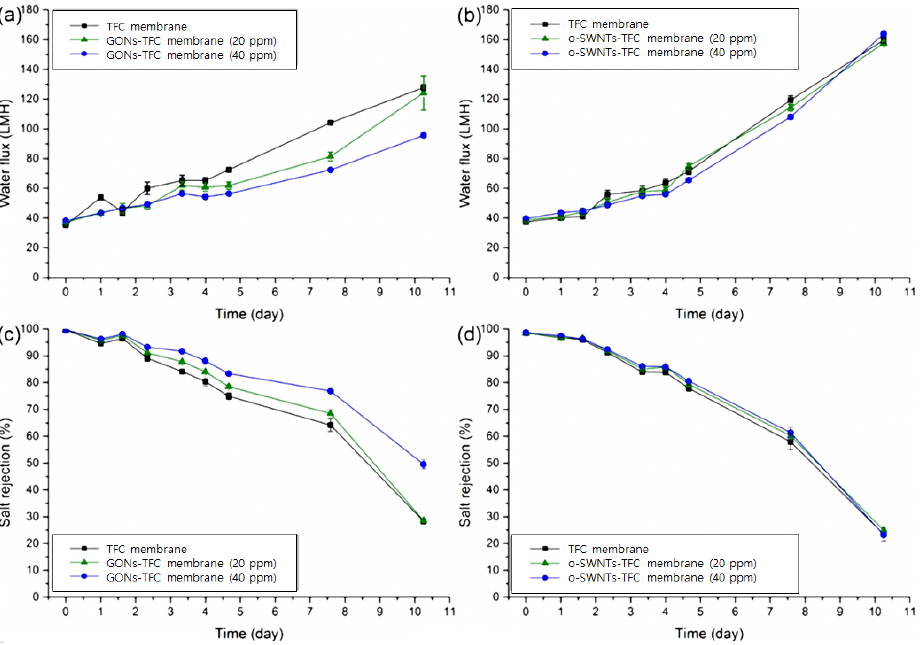
Figure 7. Water flux of ( a ) GONs- and ( b ) o-SWNTs-TFC membranes (0, 20, 40 ppm) and salt rejection of ( c ) GONs- and ( d ) o-SWNTs-TFC membranes (0, 20, 40 ppm) with a 2000-ppm MgSO 4 feed solution. The time in the x -axis represented the time of immersion in sulfuric acid ( n = 3).